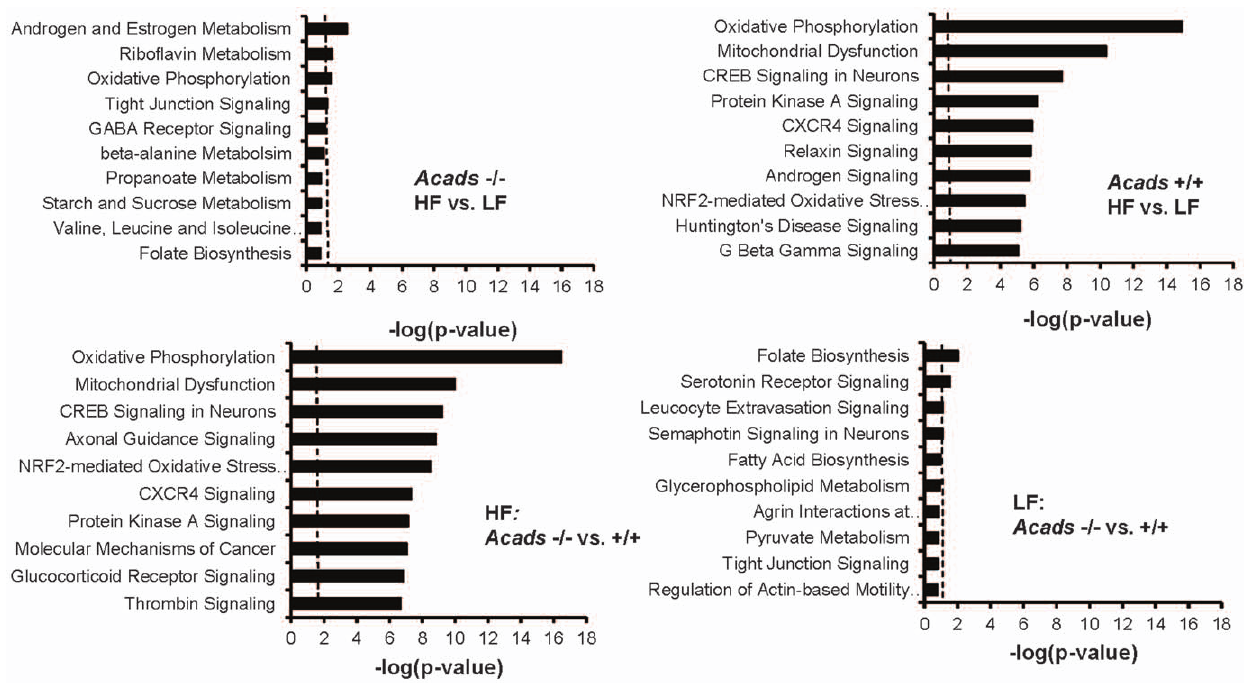
Figure 4. Top ten pathways disturbed in brain by Acads genotype and dietary fat. Classification of differentially expressed genes (DEG) according to the top ten pathways most significantly affected by Acads genotype or dietary fat level in the brain using Ingenuity Pathways Analysis (IPA). Bars indicate the likelihood [ 2 log ( P -value)] that the specific category was affected by Acads deficiency or dietary fat level compared with others represented in the list of DEG. The vertical dotted line represents the threshold value for significance of P , 0.05 (1.301 2 log scale).